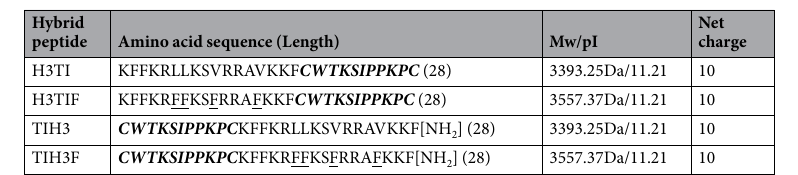
Table 3. Sequences and physicochemical parameters of the four hybrid peptides. The disulfidebridged hendecapeptide (CWTKSIPPKPC) proteinase inhibitor loop is indicated in italics and bold; the Phe mutations are